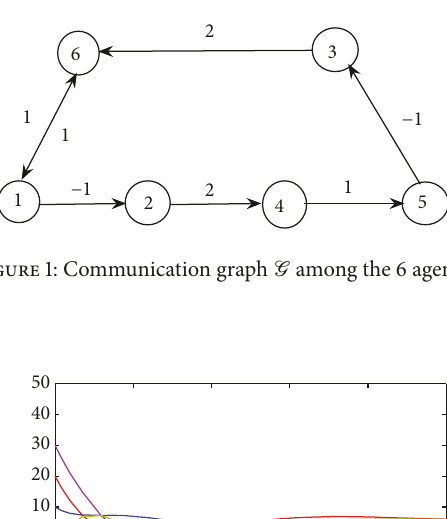
Figure 3: Control inputs of six